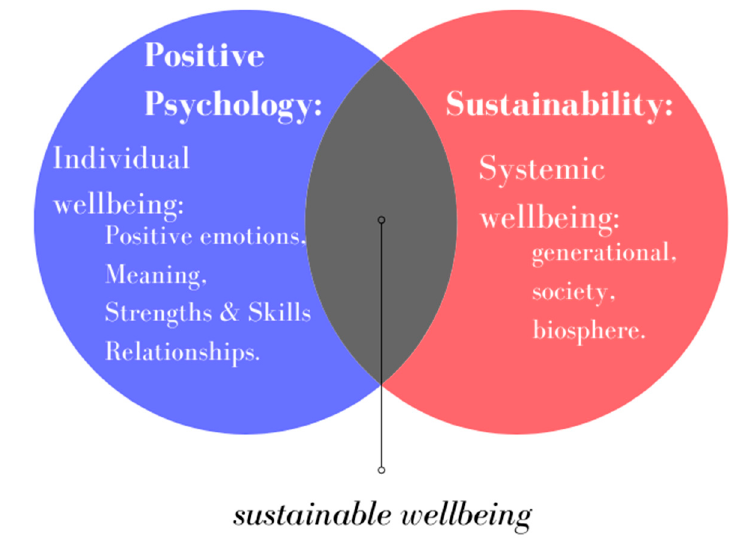
Figure 1. Sustainable wellbeing components.